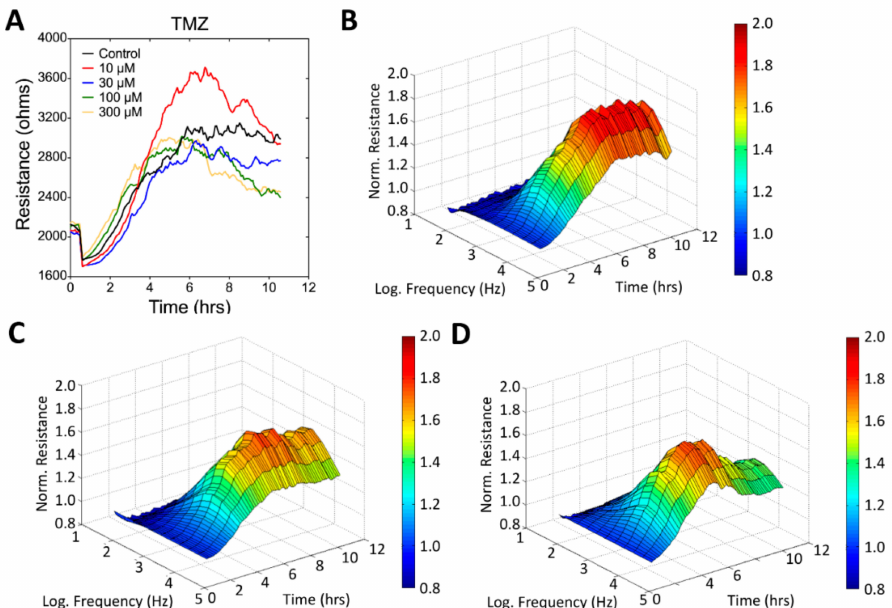
Figure 5. E ff ects of TMZ on the wound healing and migration of U-87 MG cells measured using ECIS. ( A ) Time course of the measured resistance at an AC frequency of 4 kHz during the ECIS wound healing assay. Three-dimensional demonstration of the e ff ects of TMZ at concentrations of ( B ) 0 µ M (control), ( C ) 30 µ M, and ( D ) 300 µ M on cell